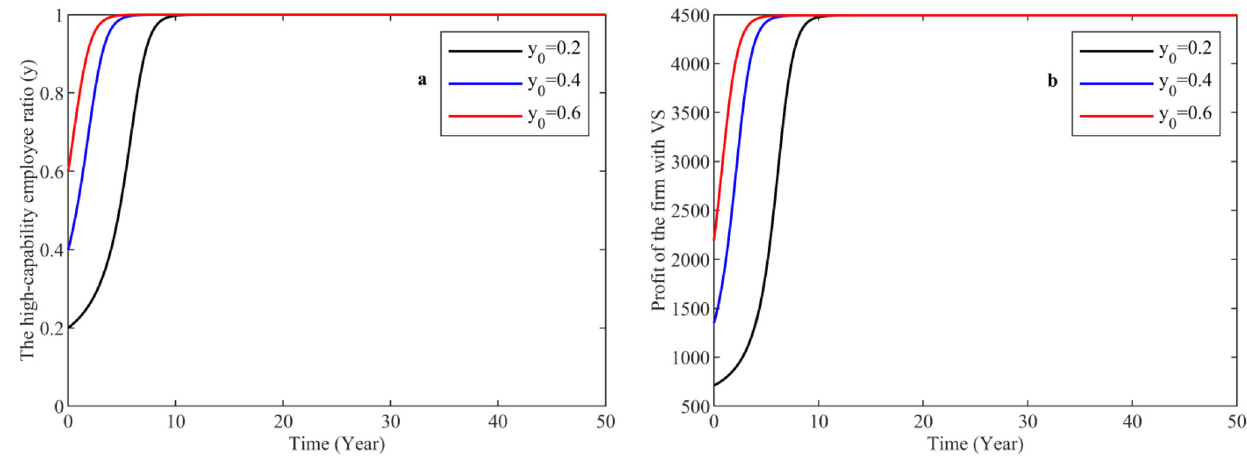
Fig. 8 The effect of the initial proportion of high-capability employees ( y 0 ) on the proportion of high-capability employees and the pro fi t of the fi rm. a Evolution of high-capability employees with different y 0 . b Evolution of pro fi t with different y 0 .